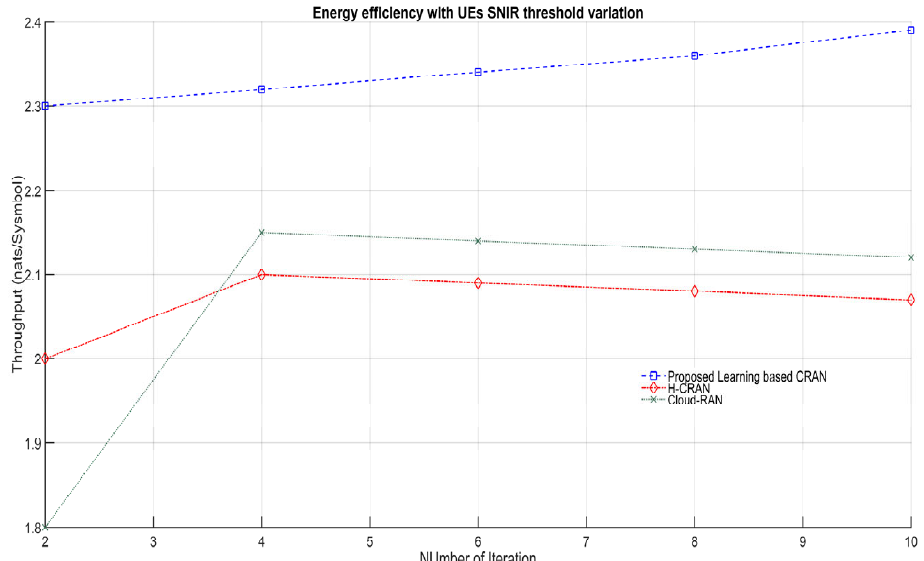
Figure 10. Throughput analyses based on the variation in iteration. Table 4. CDF-based data rate by accessing resource allocation. S. No. Cumulative Distribution Function (CDF) Methods Cloud-RAN